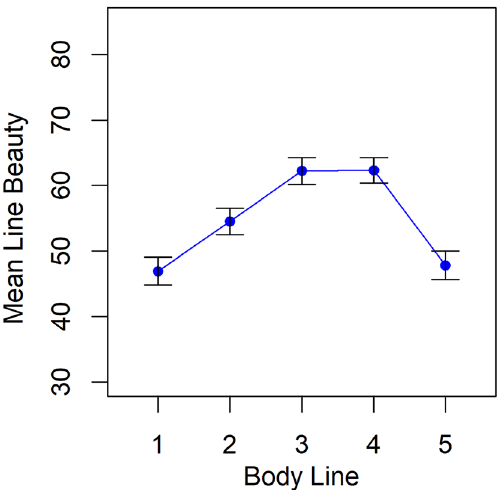
Figure 7. Mean attractiveness ratings of the five body lines in Study